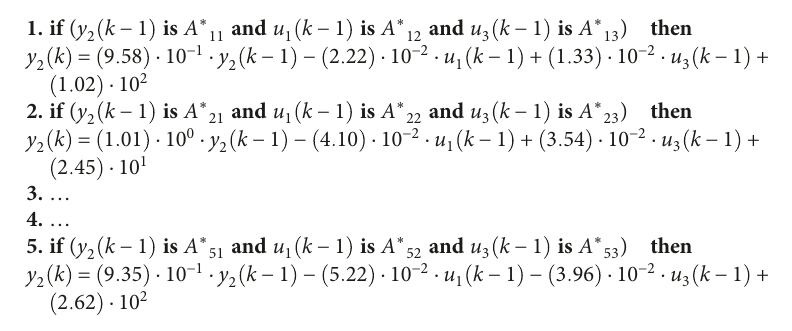
Algorithm 3: Takagi-Sugeno fuzzy model for biomass y